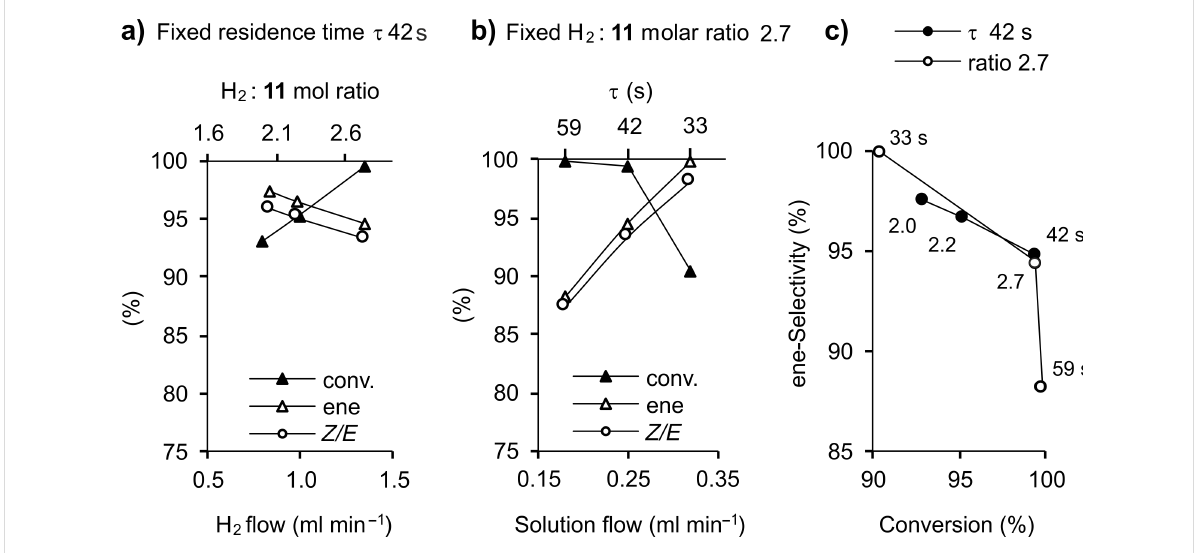
Figure 10: Continuous-flow hydrogenation of 11 over Pd@MonoBor catalyst. a) Conversion and selectivity as a function of H 2 flow rate and H 2 : 11 molar ratio under fixed residence time τ 42 s (solution flow rate 0.25 mL min − 1 ). b) Conversion and selectivity as a function of solution flow rate and residence time under fixed H 2 : 11 molar ratio 2.7. c) selectivity/conversion diagram at: ○ fixed H 2 : 11 ratio = 2.7 and residence time 33–59 s, • fixed residence time 42 s and H 2 : 11 ratio range 2.0–2.7. Data from ref. [136].